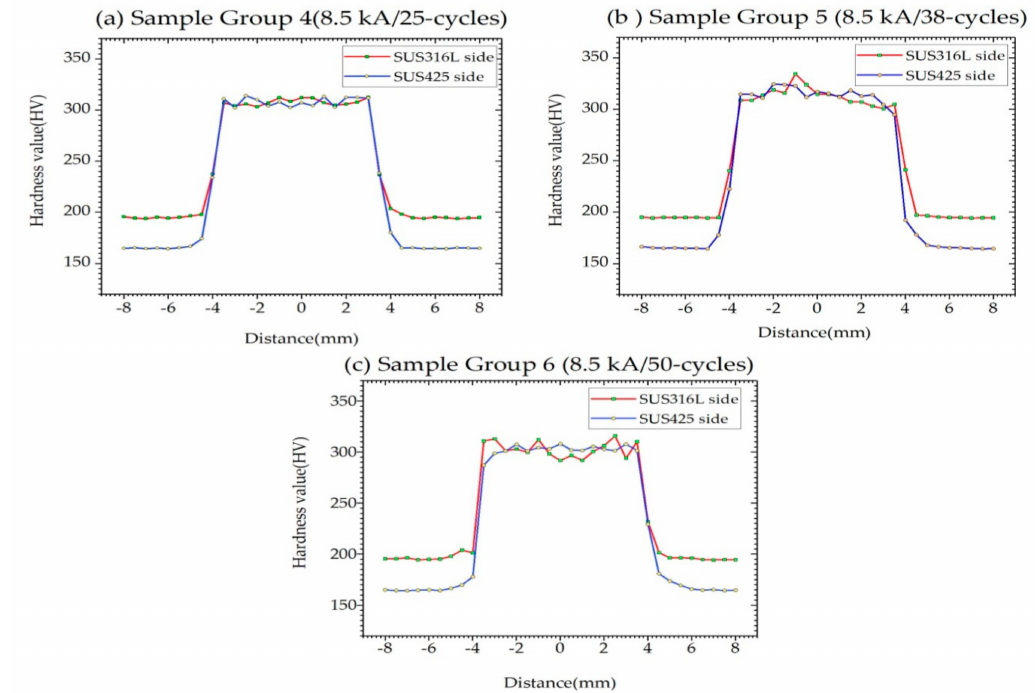
Figure 9. Micro hardness profiles of welded specimens given an 8.5 kA weld current: ( a ) 25; ( b ) 38; ( c ) 50-cycle welding times.